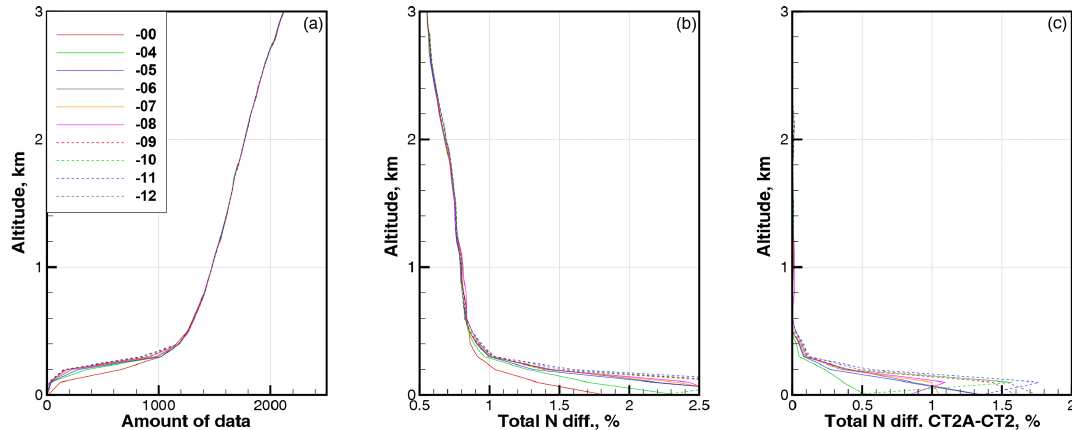
Figure 10. Statistics for latitude band 70–80 ◦ . (a) Amount of data. (b) RMS relative difference in refractivity COSMIC–ECMWF (cid:49)N CE . (c) RMS relative difference in refractivity CT2A–CT2. All are functions of the parameter β